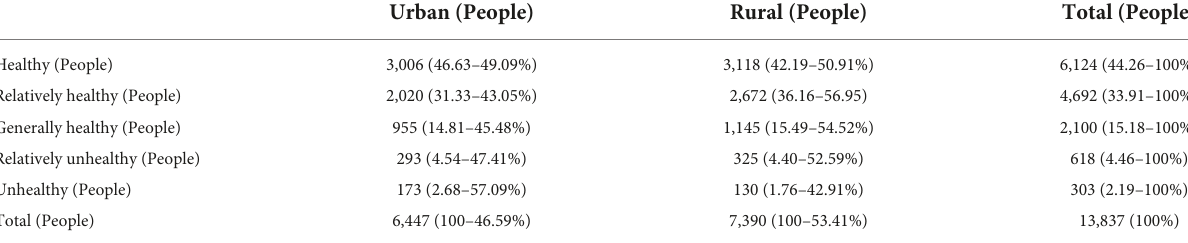
TABLE 5 Mental health status of adolescents in urban and rural